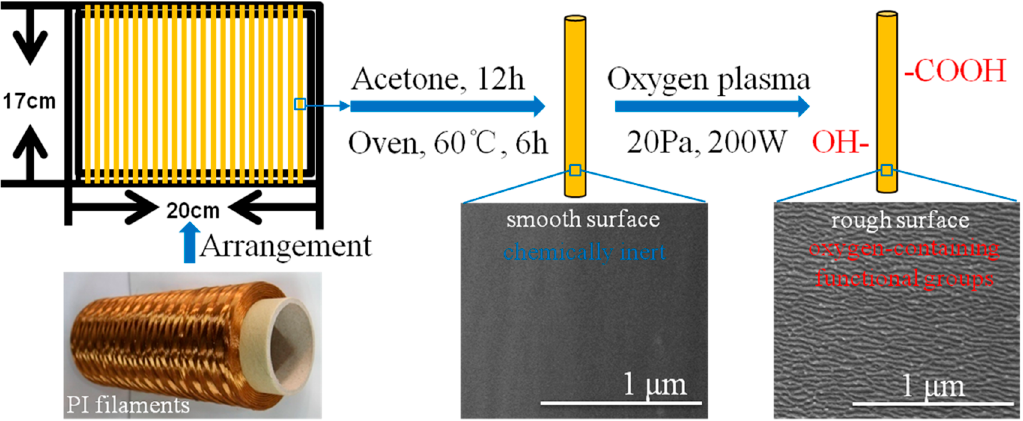
Figure 1. Specimen preparation and plasma treatment procedures of polyimide (PI) filaments.